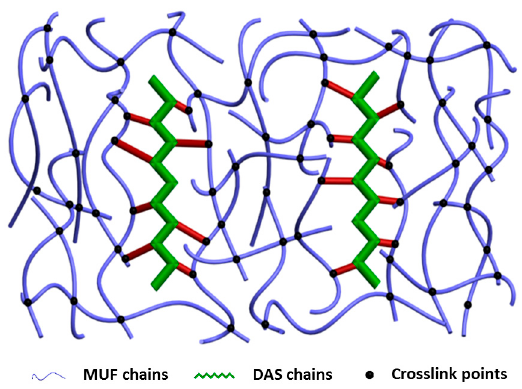
Figure 9. Fracture surface micrographs of the cured MUF resin and DAS-modified MUF resins with different DAS levels.